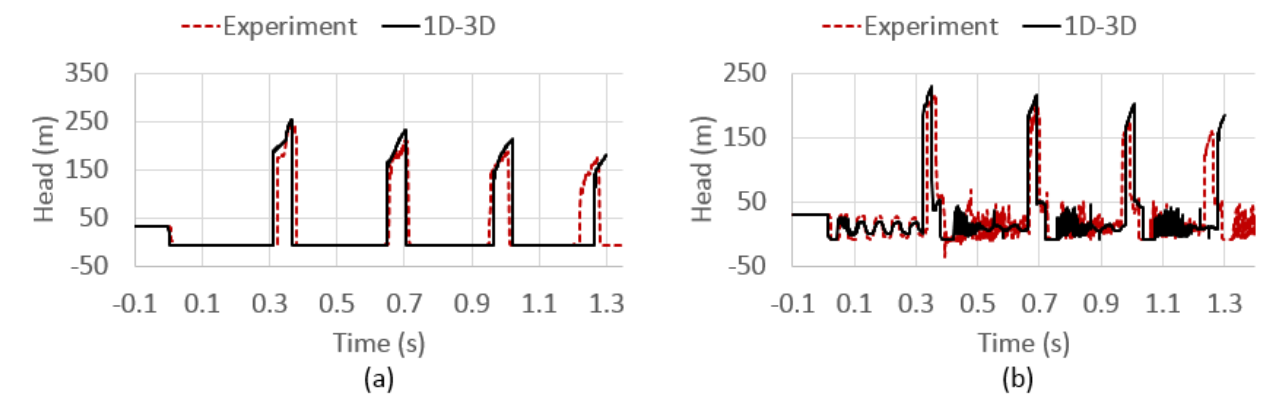
Figure 7. cavity size evolution captured by 1D-2D.